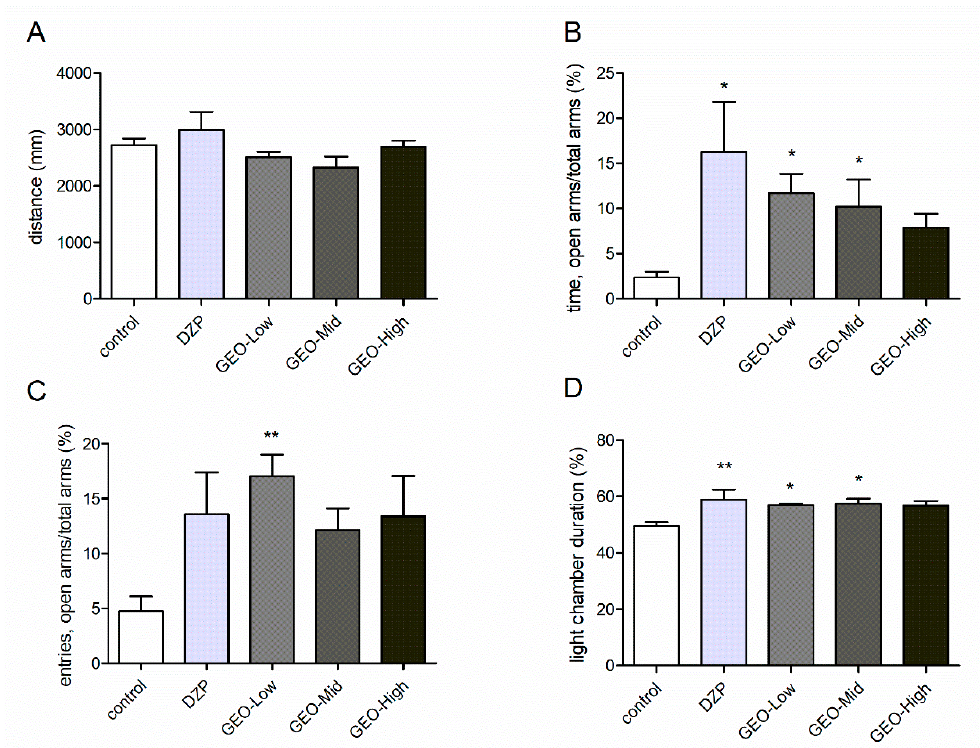
Figure 2. Anxiolytic effects of GEO odor under three concentrations (GEO-Low: 0.2 mg/L, GEO-Mid: 1.0 mg/L, GEO-High: 2.0 mg/L) exposures on the mice in the open field (OF) test ( A ), elevated plus maze (EPM) test ( B , C ) and light and dark box (LDB) test ( D ). ( A ) The total distance of the mice explored in the OF test. ( B ) The percentage of time of the mice spent in open arms in EPM tests. ( C ) The percentage of entries of the mice into the open arms in EPM tests. ( D ) The percentage of time spent in the light chamber in LDB tests. Values represent the mean ± SE ( n = 10~11), * p < 0.05 vs. control group, ** p < 0.01 vs. control group. A one-way ANOVA followed by a post hoc Duncan test was used.